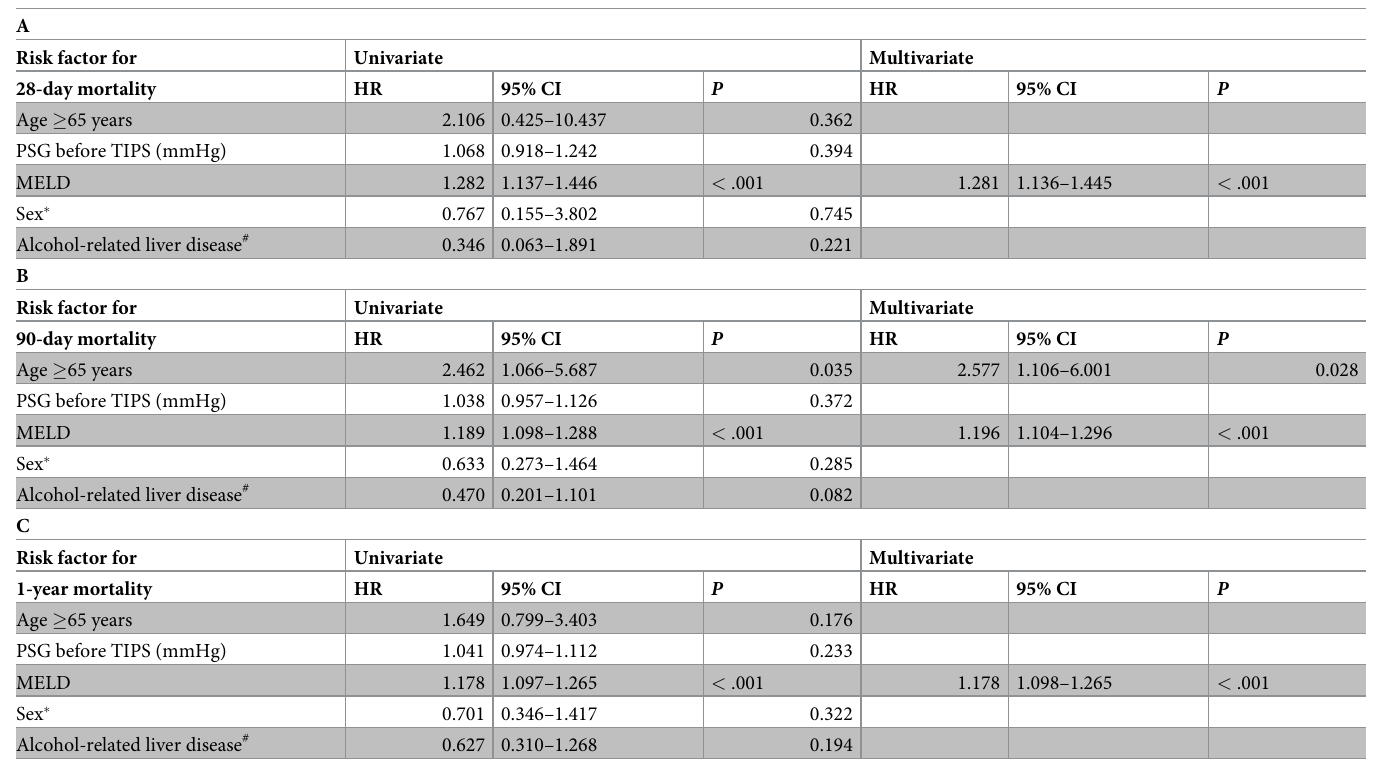
Fig 2. Survival of TIPS patients in dependence of age ( < 65 years vs. � 65 years). Shown is survival (a) 28 days, (b) 90 days and (c) 1 year after TIPS insertion. p -values were obtained using the log-rank test (Breslow test: see text). A value of p < 0.05 was considered statistically significant.